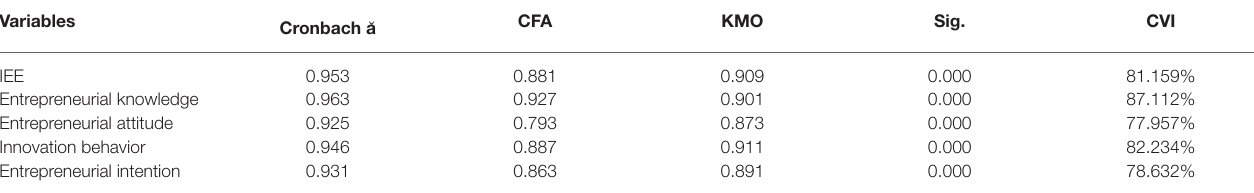
TABLE 3 | Reliability and validity analysis